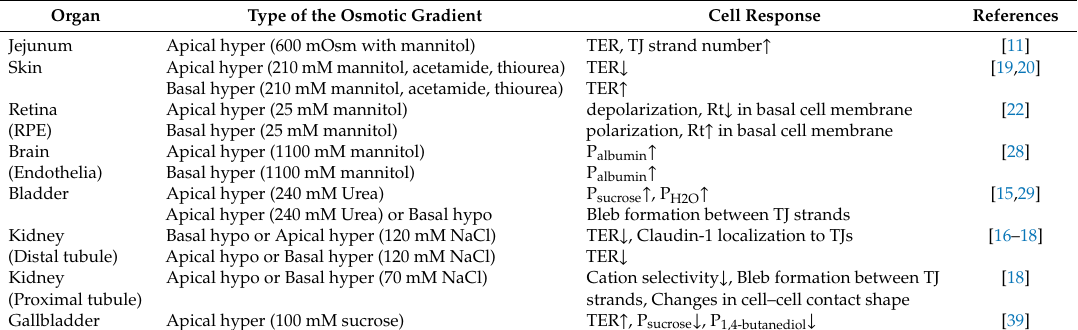
Table 1. E ff ects of the osmotic gradient on epithelia and